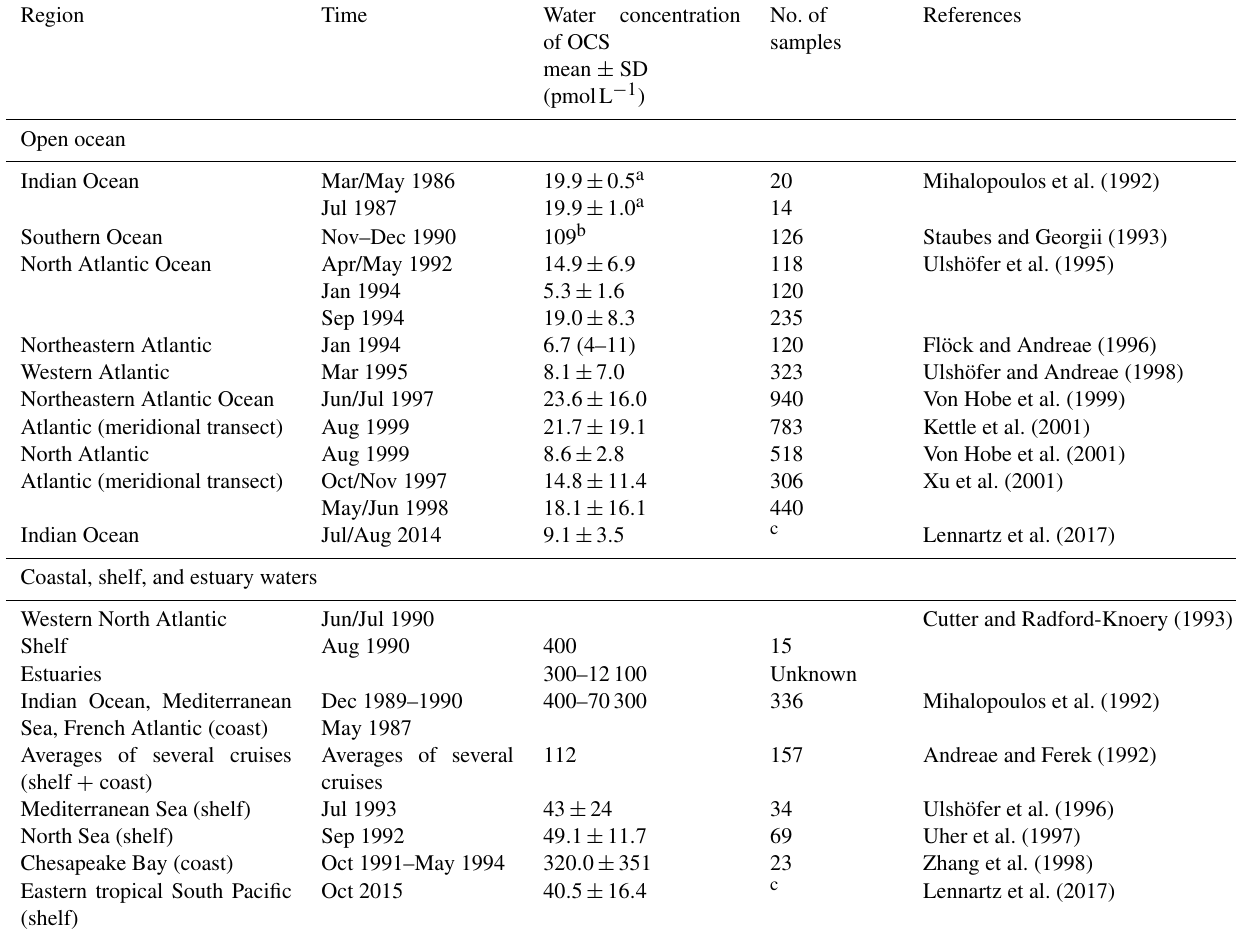
Table 3. Measurements of OCS water concentration at the ocean surface (0–5m) in the open ocean as well as coastal, shelf, and estuary